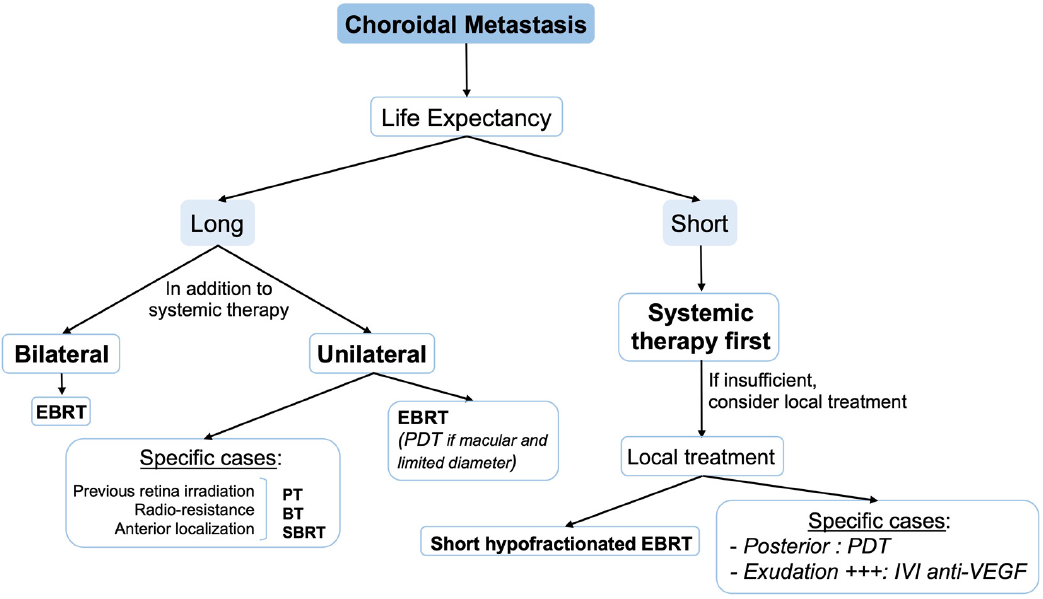
Figure 2. Treatment algorithm for choroidal metastasis. BT: brachytherapy; EBRT: external beam radiotherapy; IVI: intravitreal injection; PDT: photodynamic therapy; PT: proton therapy; SBRT: stereotactic body radiotherapy; VEGF: vascular endothelial growth factor.